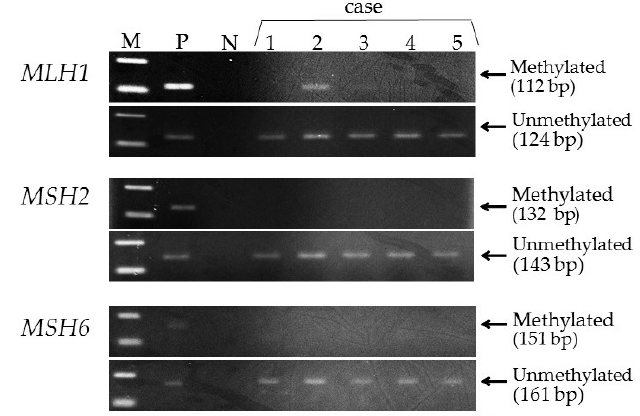
Figure 1. Methylation specific polymerase chain reaction (MSP) using peripheral blood lymphocytes.